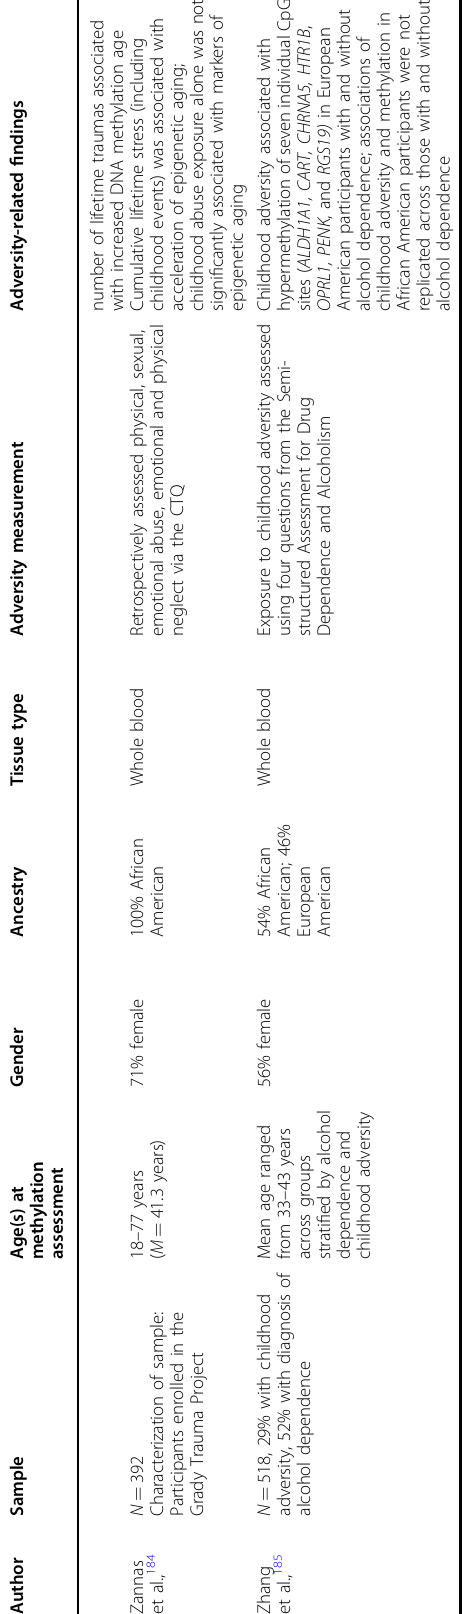
Changes in gene expression